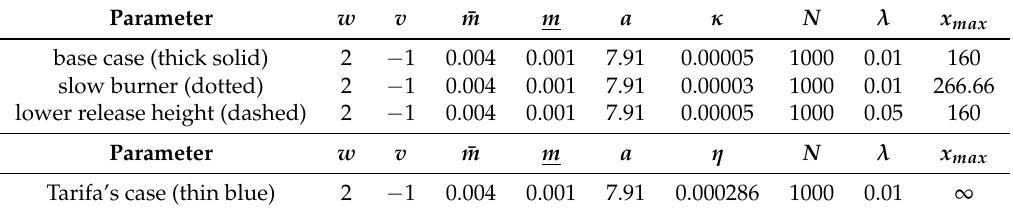
Table 1. Summary of the model parameters for the examples (in metric units).